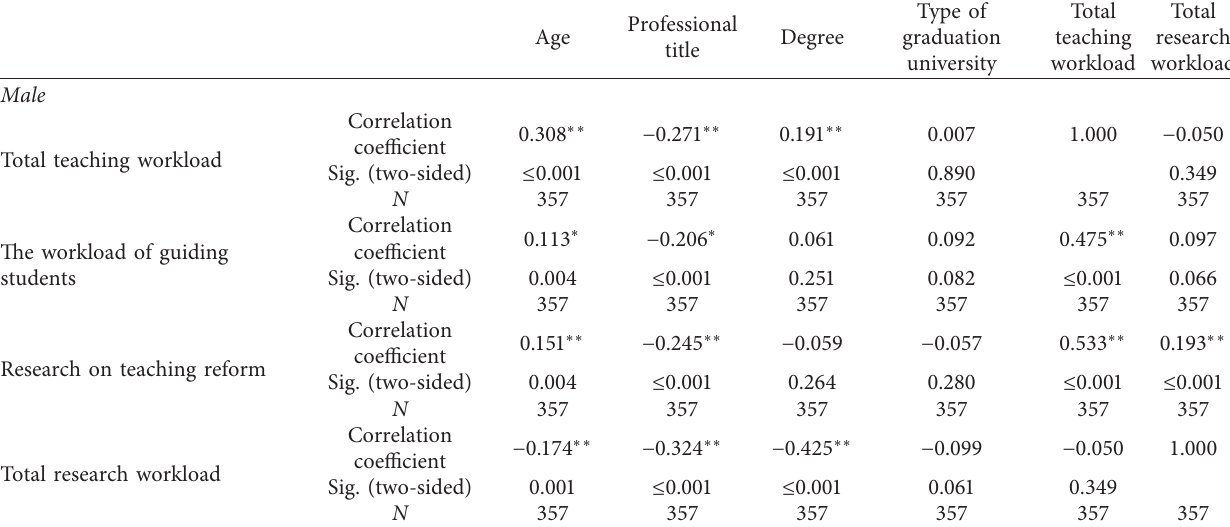
Table 7: Correlation analysis of influencing factors of teachers’ teaching and research